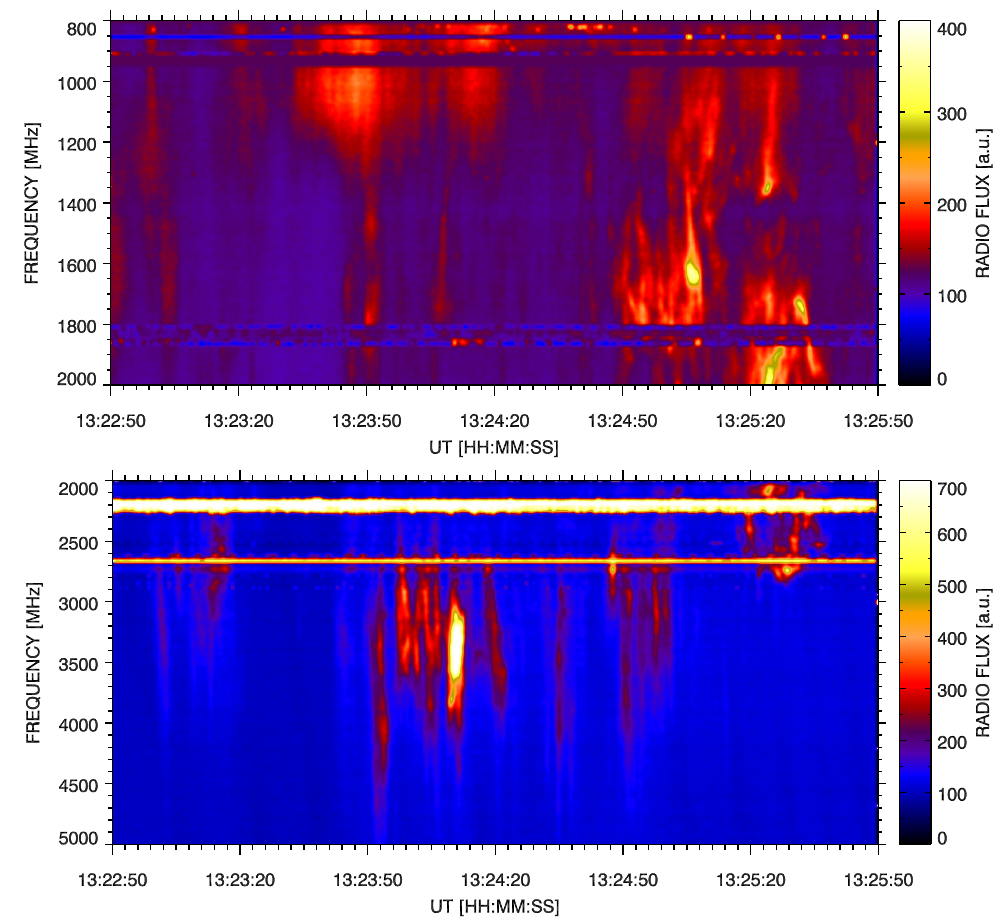
Figure 3. Detailed 800–2000MHz radio spectrum ( top panel) and detailed 2000–5000MHz radio spectrum ( bottom panel) in the time interval 13:22:50–13:25:50UT. See the bifurcation region at 1200–1400MHz and 13:24:50–13:25:30UT, where type III bursts start to drift to higher or lower